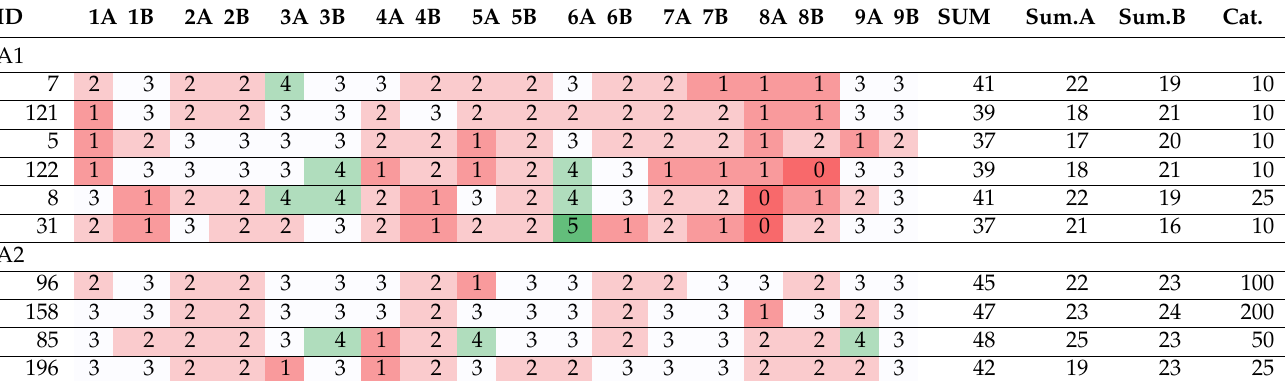
Table 5. The individual responses of respondents from cluster A.